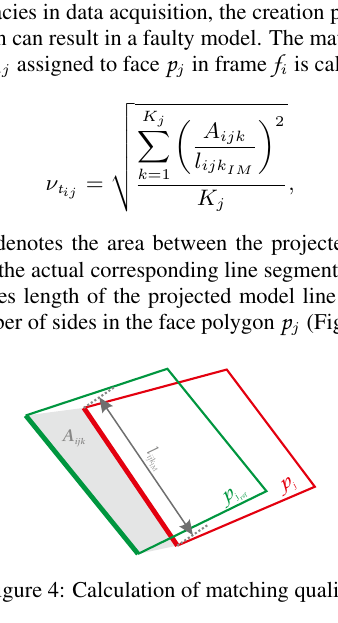
Figure 5: 3D building model with TIR